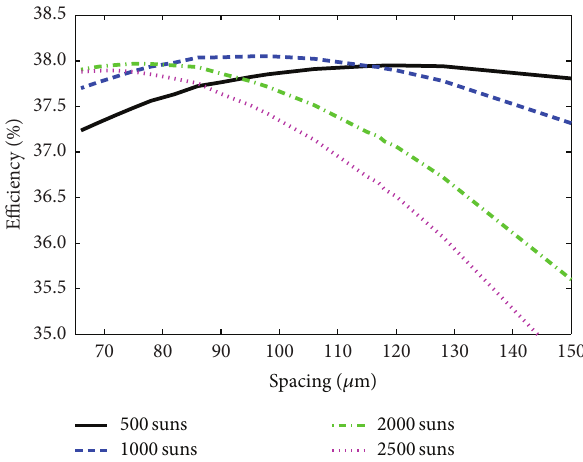
Figure 4: Efficiency as a function of spacing at 500, 1000, 2000, and 2500 suns under uniform illumination. An optimal finger spacing is obtained using a Golden section search algorithm after 8–10 itera-